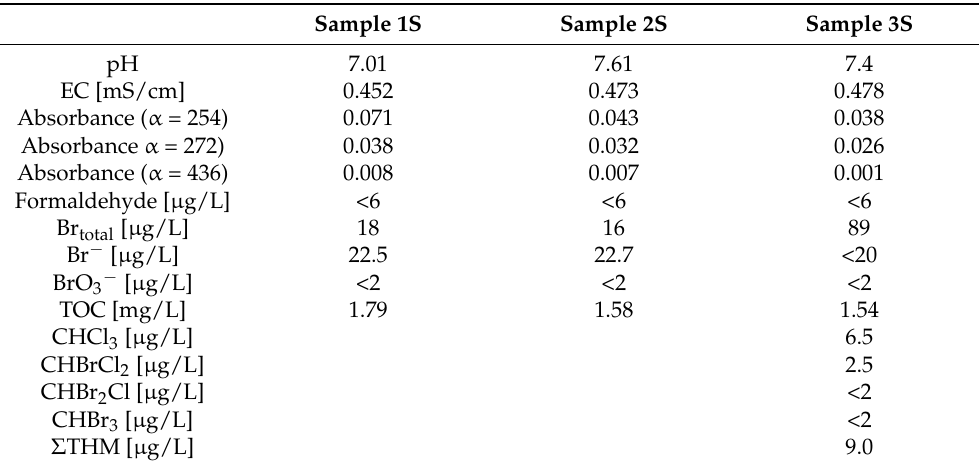
Table 1. Selected physico-chemical parameters of water from the WTP Skawina treated with ozone (sample collected on 3 January 2018).